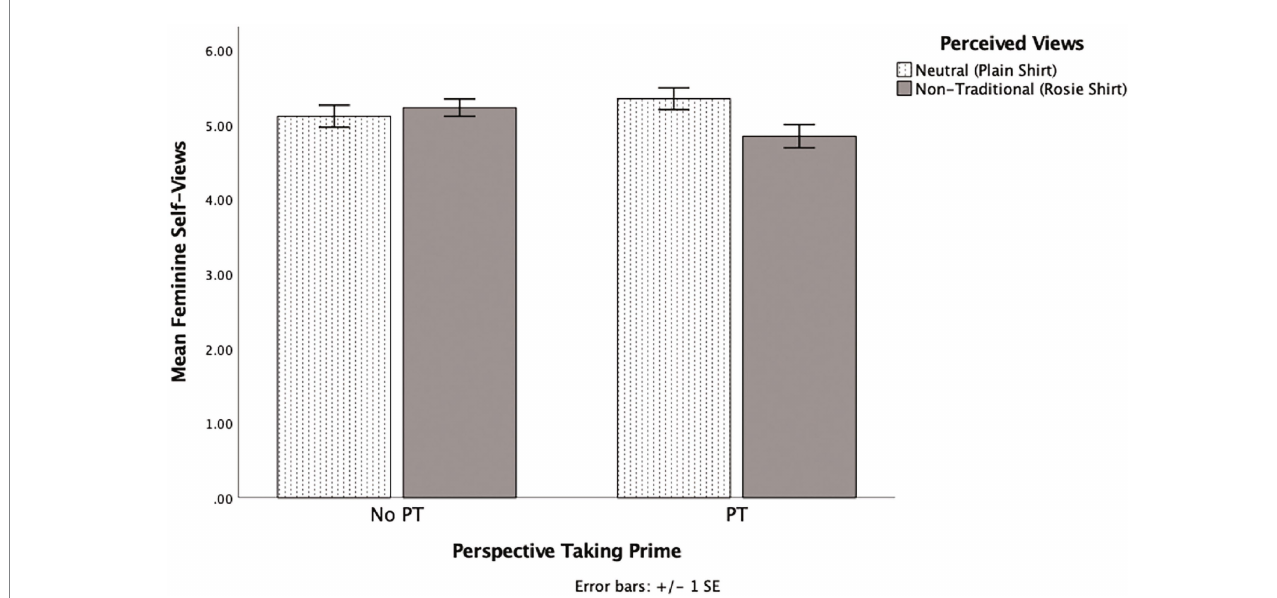
FIGURE 1 The effects of perspective taking and perceived views on feminine self-view in Experiment